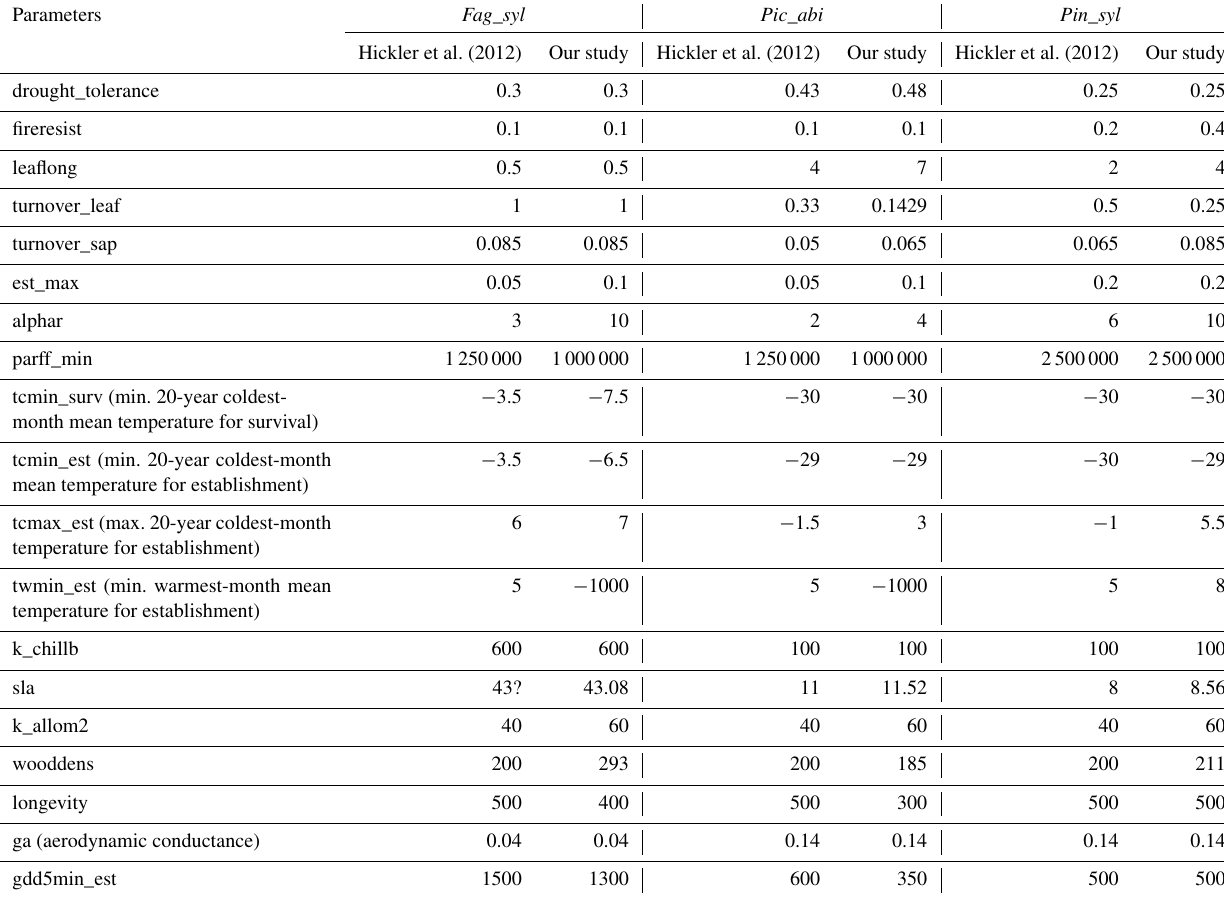
Table A1. Differences in parametrization of Hickler et al. (2012) and our study for the investigated species ( Fag. syl. , Pic. abi. and Pin. syl